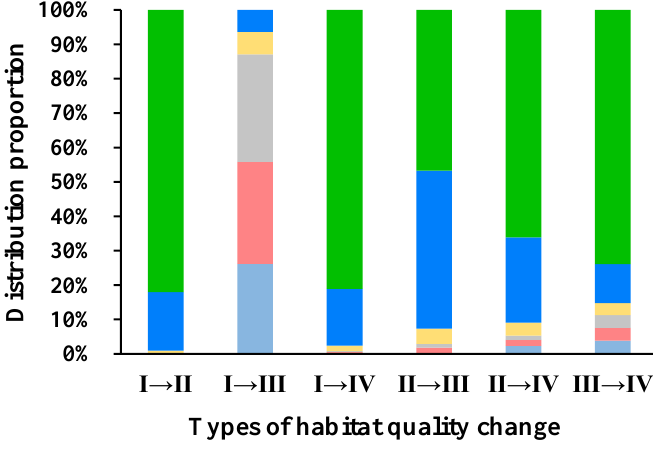
Figure 11. Proportion of habitat quality increases for different topographic positions.